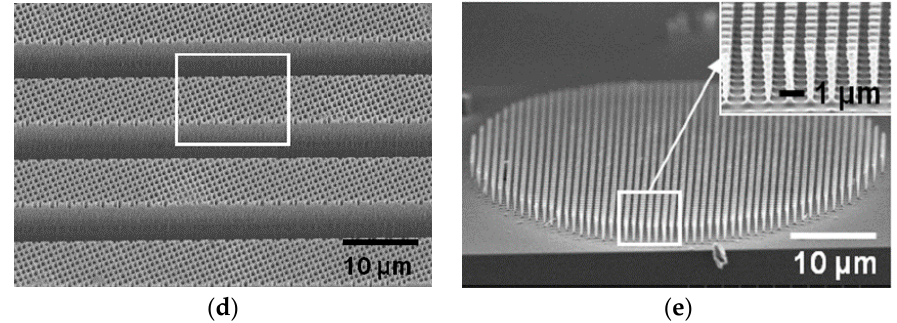
Figure 10. ( a ) Schematic of dual patterning of both nanopillars and nanoholes on silicon substrates by using tri-layer membrane based stencil lithography technique. Reprinted with permission from [98].